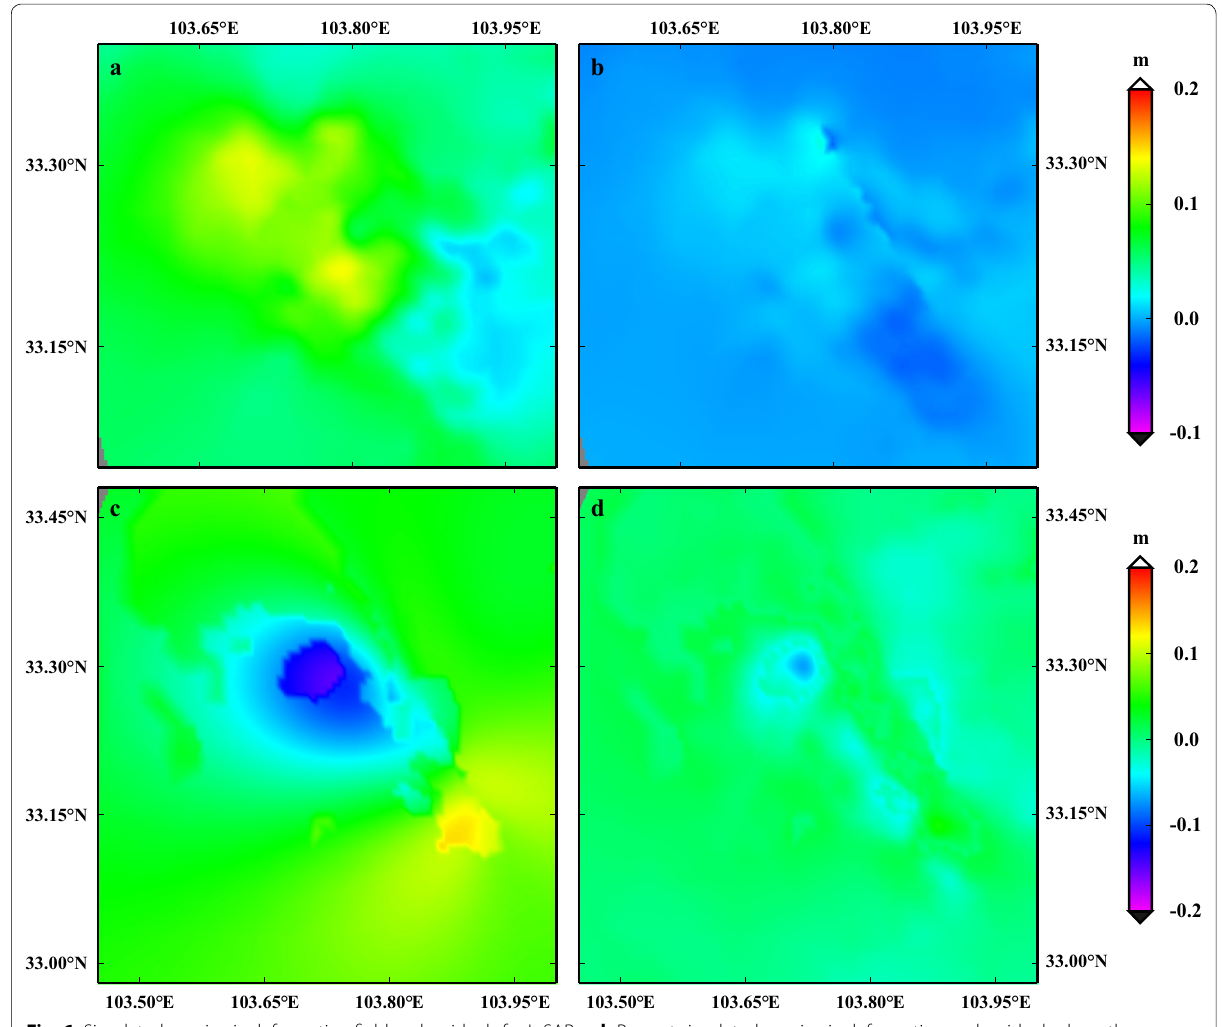
Fig. 6 Simulated coseismic deformation field and residuals for InSAR. a , b Present simulated coseismic deformation and residuals along the descending orbit. c , d Present simulated coseismic deformation and residuals along the ascending